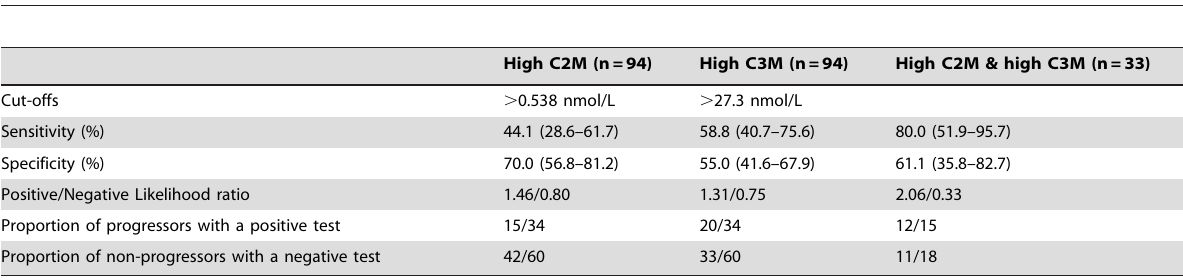
Table 5 . Clinical predictive utility of the serum